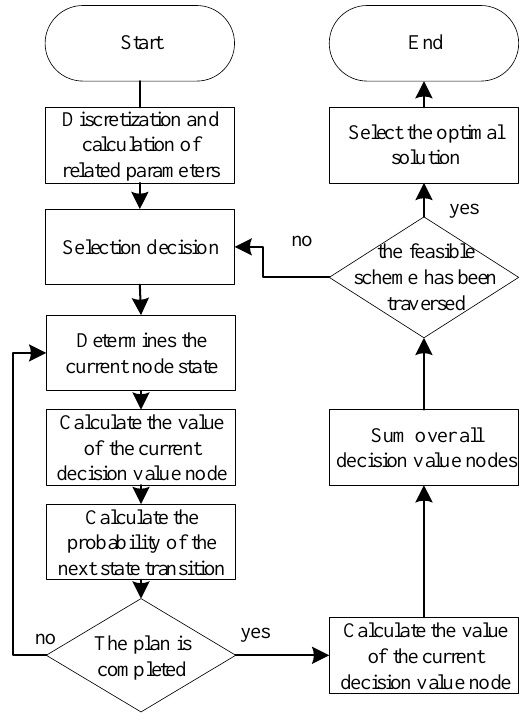
Figure 7. Schematic diagram of the model in network form.